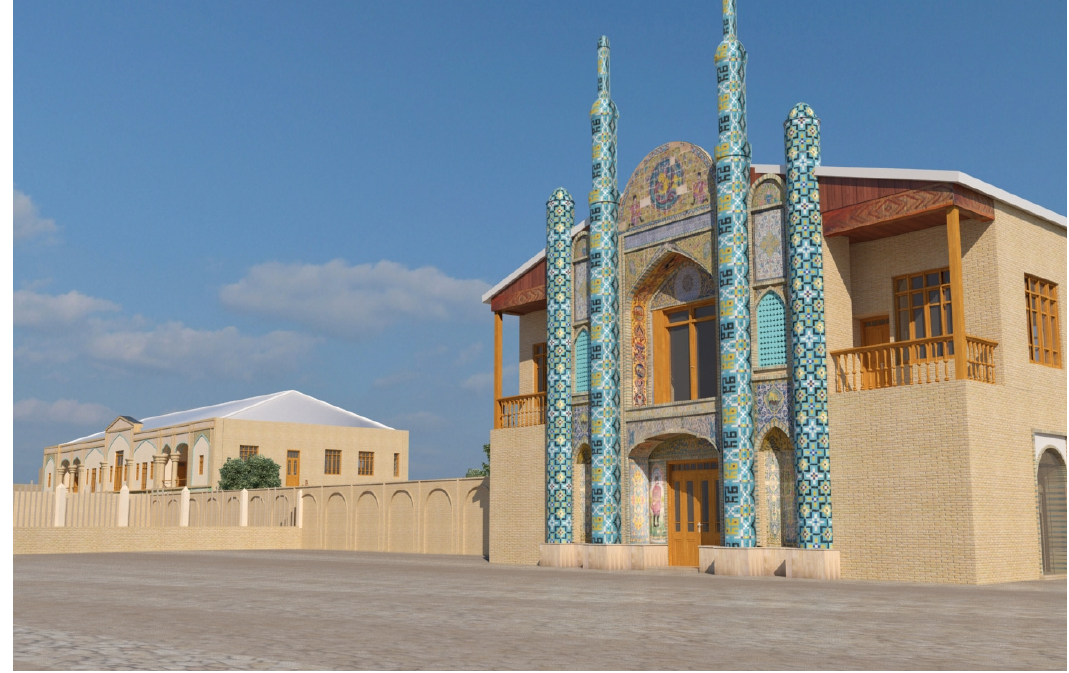
Image 4: 3D image of two main buildings; mirror house (ayne khane) at right and residential building at left in